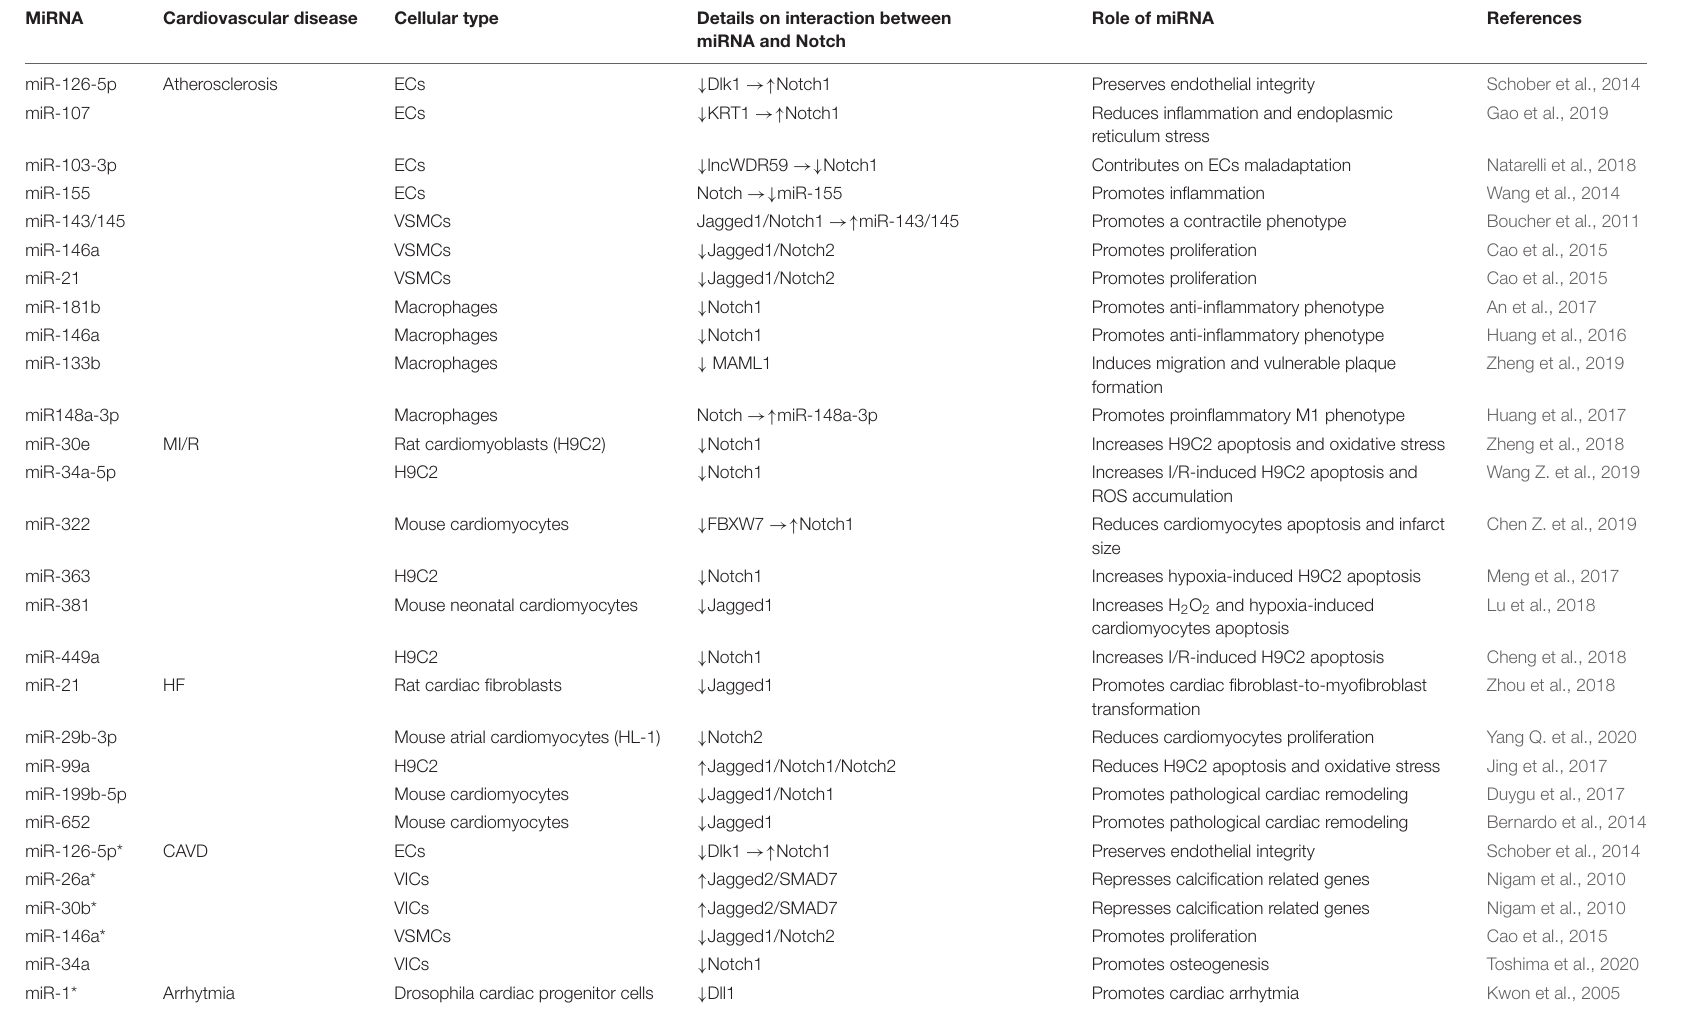
TABLE 1 | Crosstalk between miRNAs and Notch pathway in cardiovascular diseases.